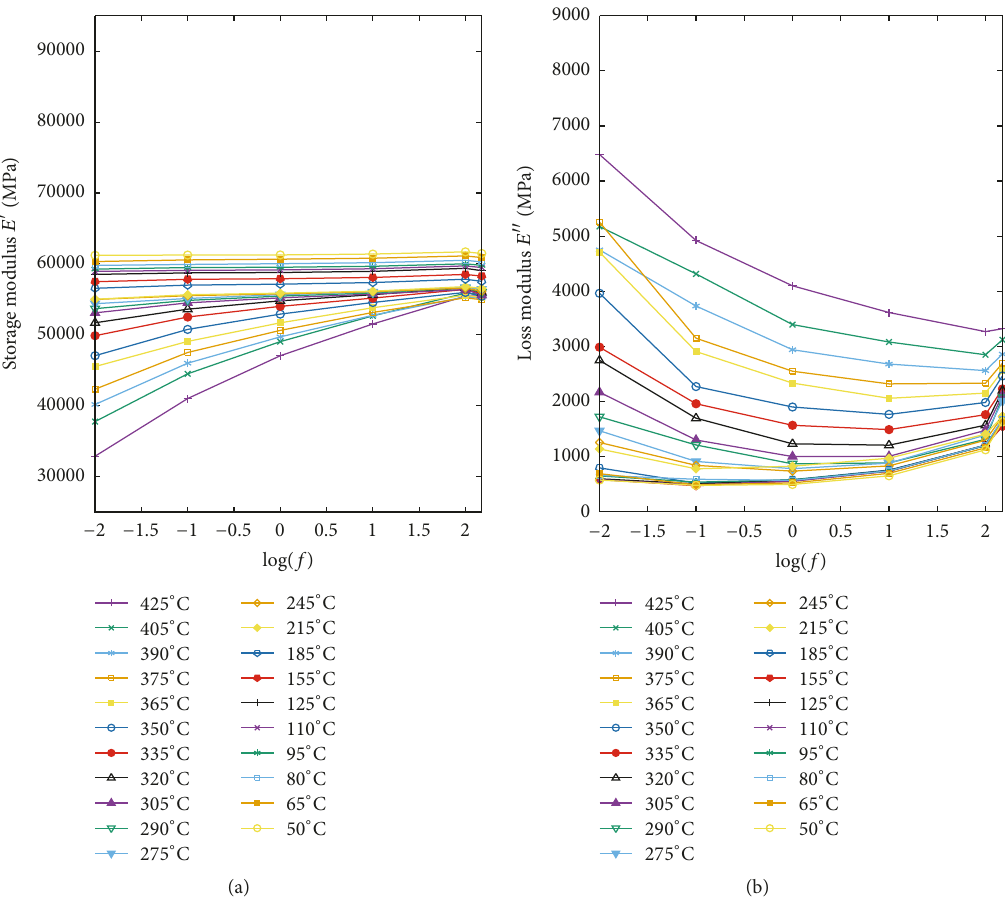
Figure 4: Isothermal storage modulus 𝐸 󸀠 (a) and loss modulus 𝐸 󸀠󸀠 (b) versus logarithm of the frequency 𝑓 from DMA tests on solution treated AA 2024 at frequencies ranging from 0.01 to 150 Hz and from 50 to 425 ∘ C.